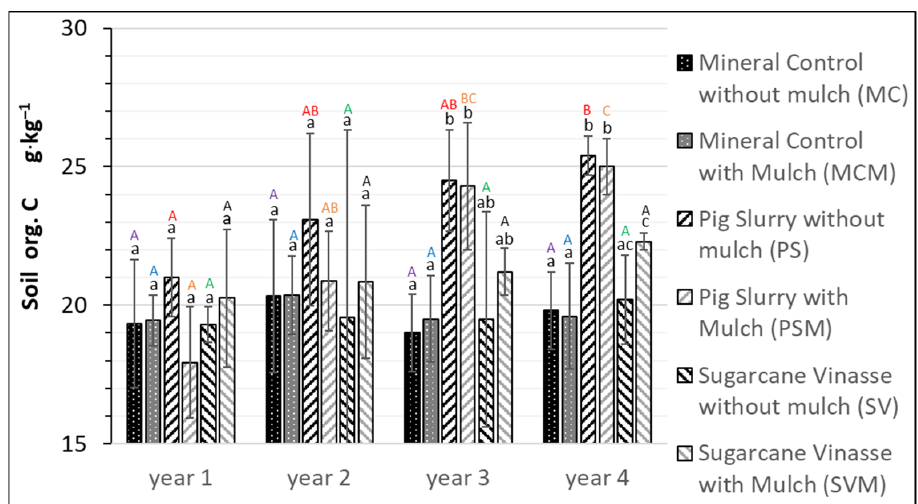
Figure 3. Soil organic carbon under each treatment in the four years. Error bars correspond to the standard deviation between replicates for each treatment. Identical letters indicate no significant differences between two modalities in a given year. Small letters compare treatment in a given year and capital letters compare treatments between years.